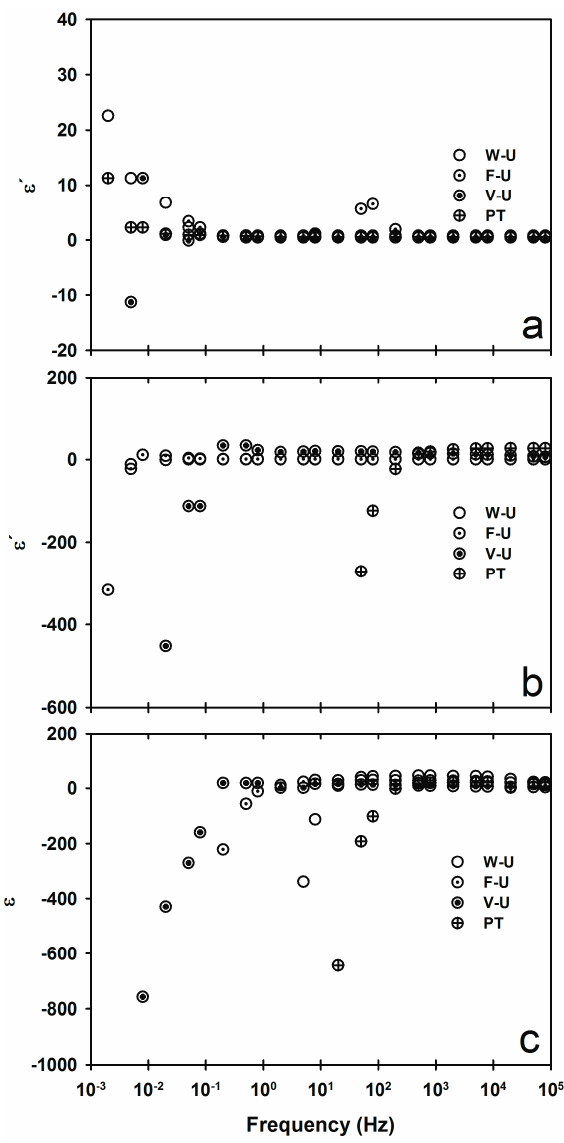
Figure 2. ε′ for ( a ) iPP MFI=2.5 /MWCNT; ( b ) iPP MFI=34 /MWCNT; and ( c ) iPP MFI=1200 /MWCNT fabricated using different ultrasound-assisted extrusion methods.